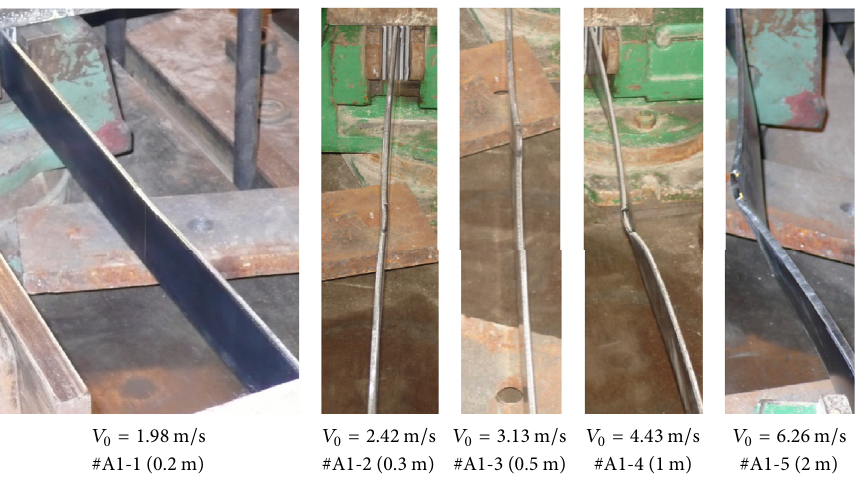
Figure 7: Deformation modes of #A1 (𝛼 = 10, 𝛽 = 10)